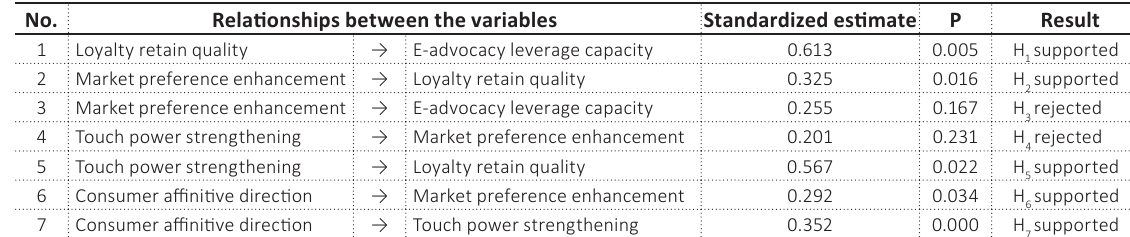
Table 3. Structural relationship output